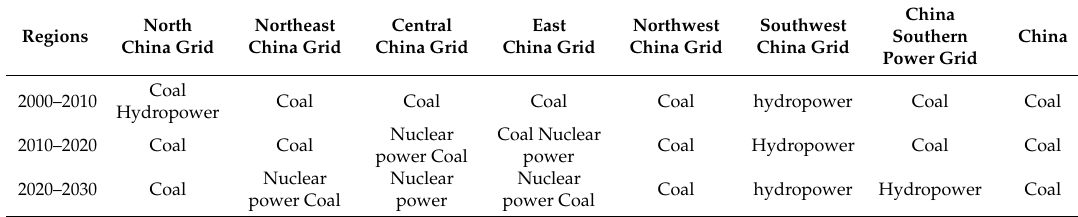
Table 2. Marginal technology in China’s power generation sector towards